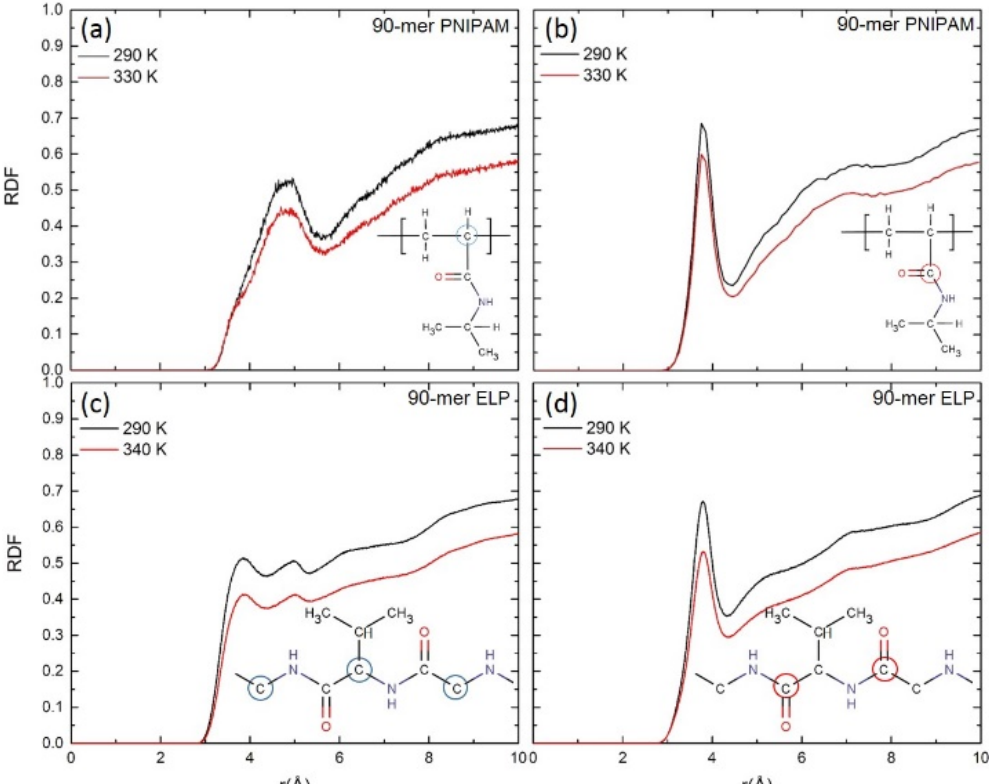
Figure 5. Radial distribution functions (RDF) for ( a , c ) the backbone carbon atoms (circled atoms on chemical drawings) and ( c , d ) carbonyl groups of ( a , b ) PNIPAM and ( c , d ) ELP with the oxygen of water.